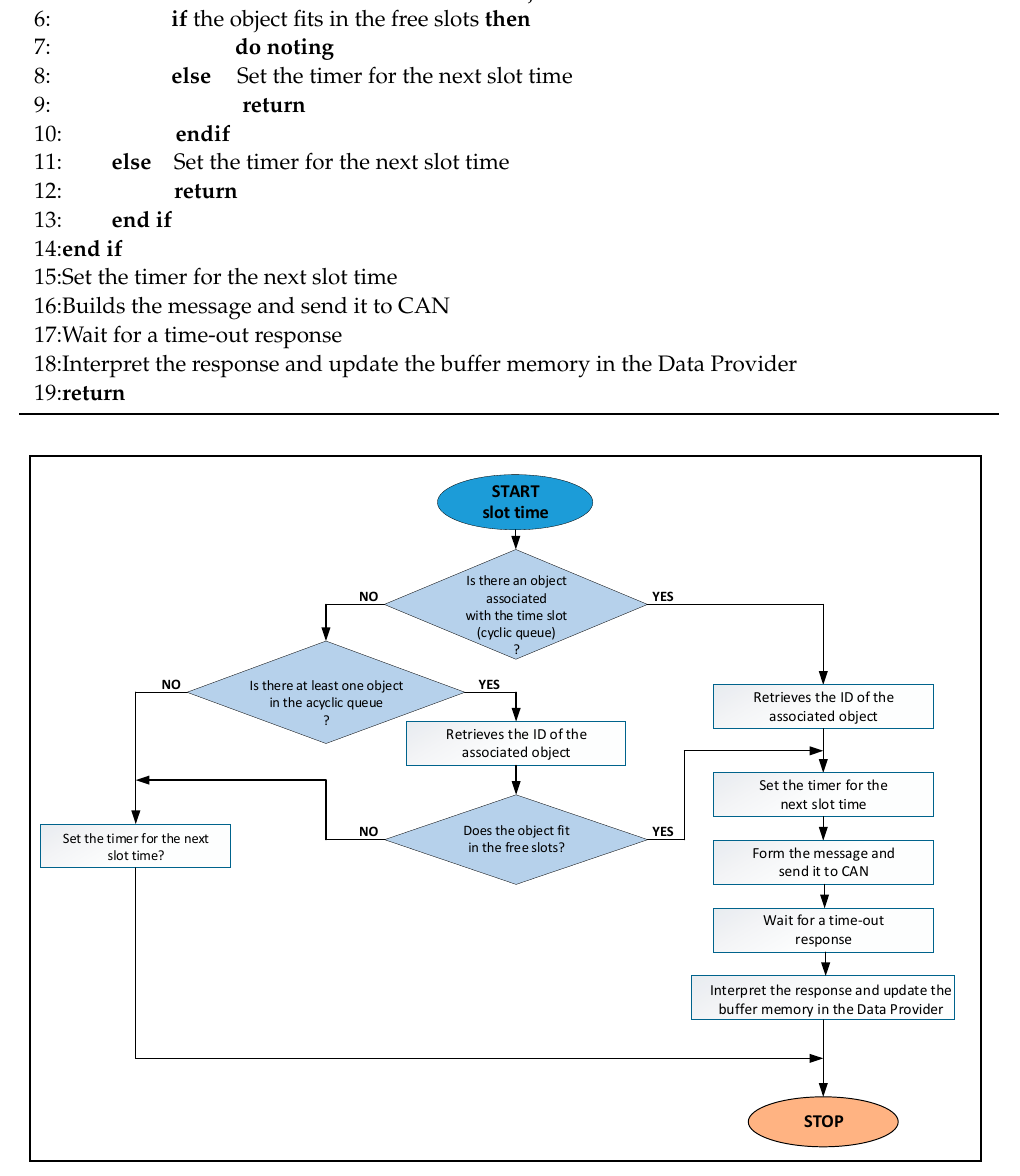
Figure 4. The activity diagram for the CANOpen fieldbus driver.